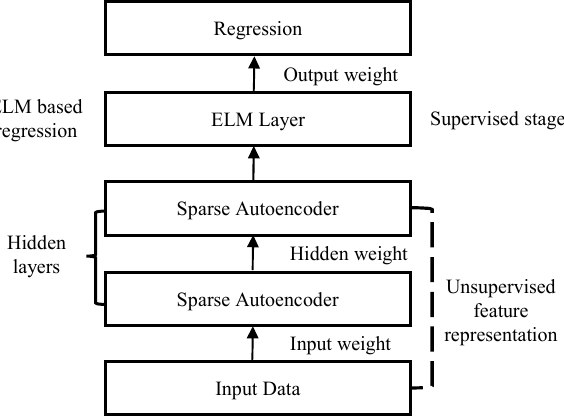
Figure 1. Hierarchical extreme learning machine (H-ELM) architecture.